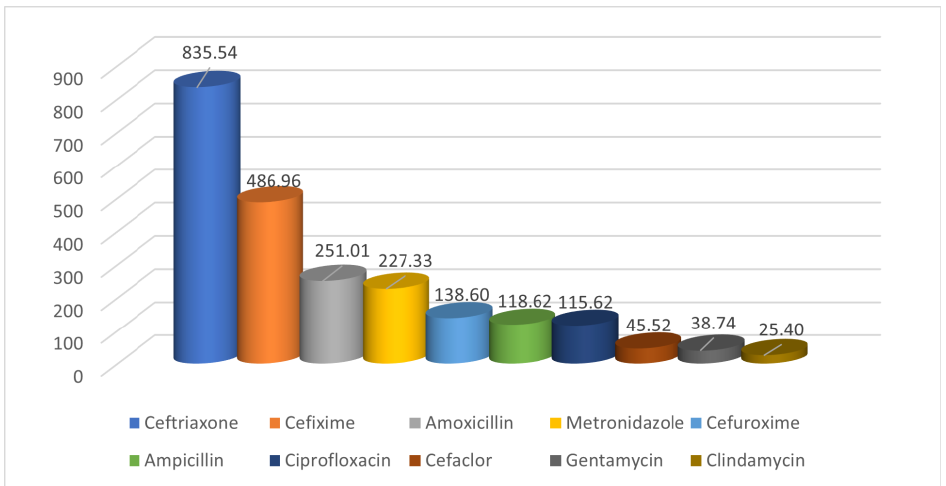
Figure 1. The first ten antibiotics prescribed from 2017 – 2021. Table 3. Prescribed antibiotics by class expressed in DDD/100 bed days during the five years